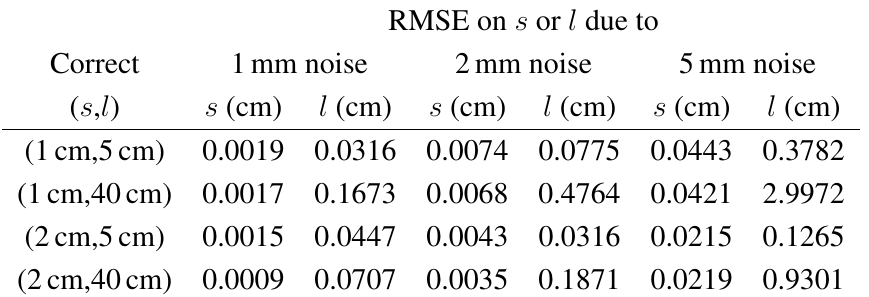
Table 3. RMSE values of s and l for different values of instrument accuracy.